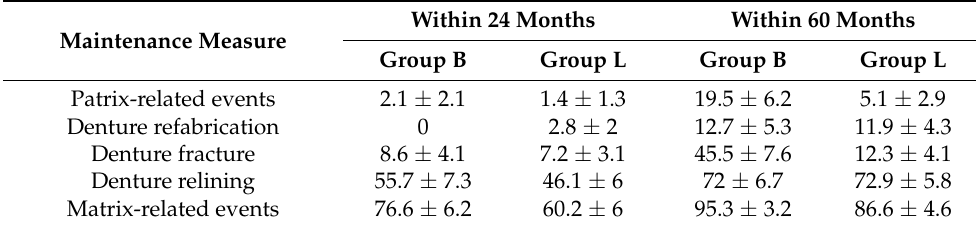
Table 2. Incidence of maintenance in % ( ± SD), stratified by group (B/L) and maintenance measure.